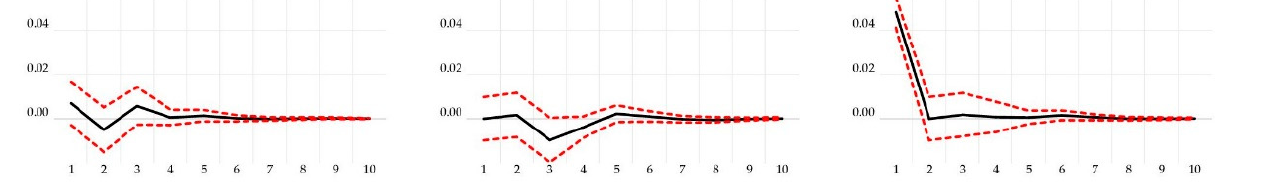
Figure A1. Response to Cholesky one std. dev. Innovations ± 2 analytic asymptotic std. errors in model 1.